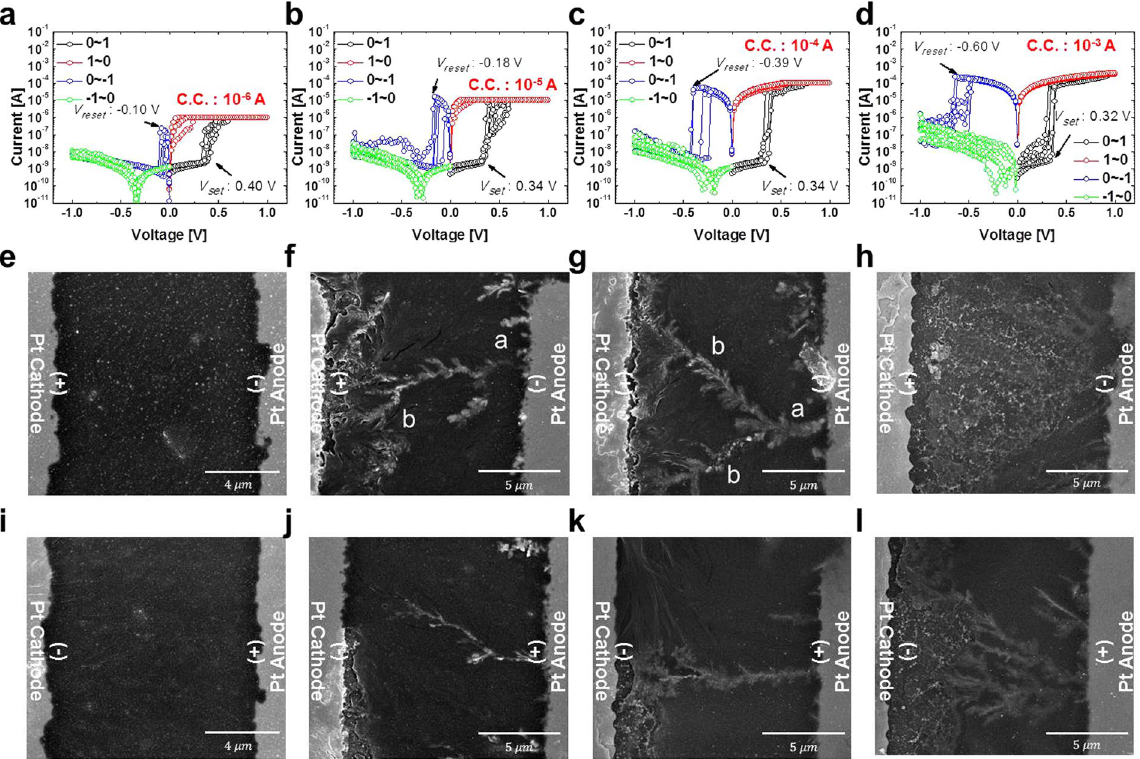
Figure 5. Dependence of bipolar switching characteristics and Ag filament morphology on compliance current level (C.C.). I – V curves for C.C. of ( a ) 1 × 10 − 6 A, ( b ) 1 × 10 − 5 A, ( c ) 1 × 10 − 4 A, and ( d ) 1 × 10 − 3 A. Ag filament morphologies after electro-forming process (set bias) for C.C. of ( e ) 1 × 10 − 6 A, ( f ) 1 × 10 − 5 A, ( g ) 1 × 10 − 4 A, and ( h ) 1 × 10 − 3 A. Ag filament morphologies after electro-breaking process (reset bias) for C.C.